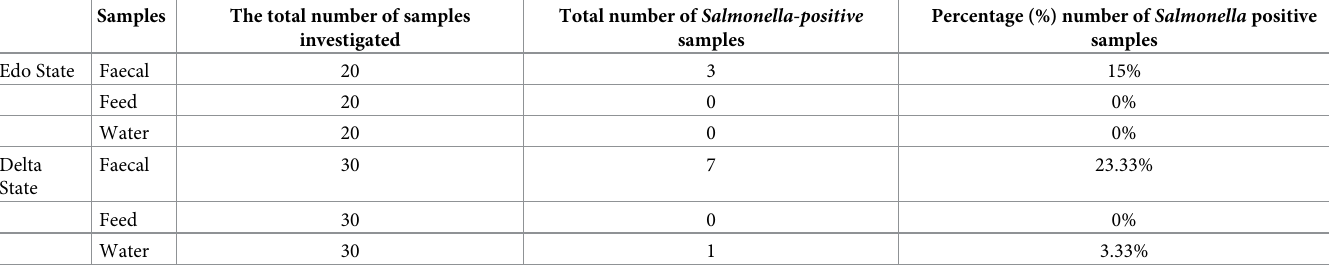
Table 1. Salmonella occurrence from samples in the poultry farms in Edo and Delta State.